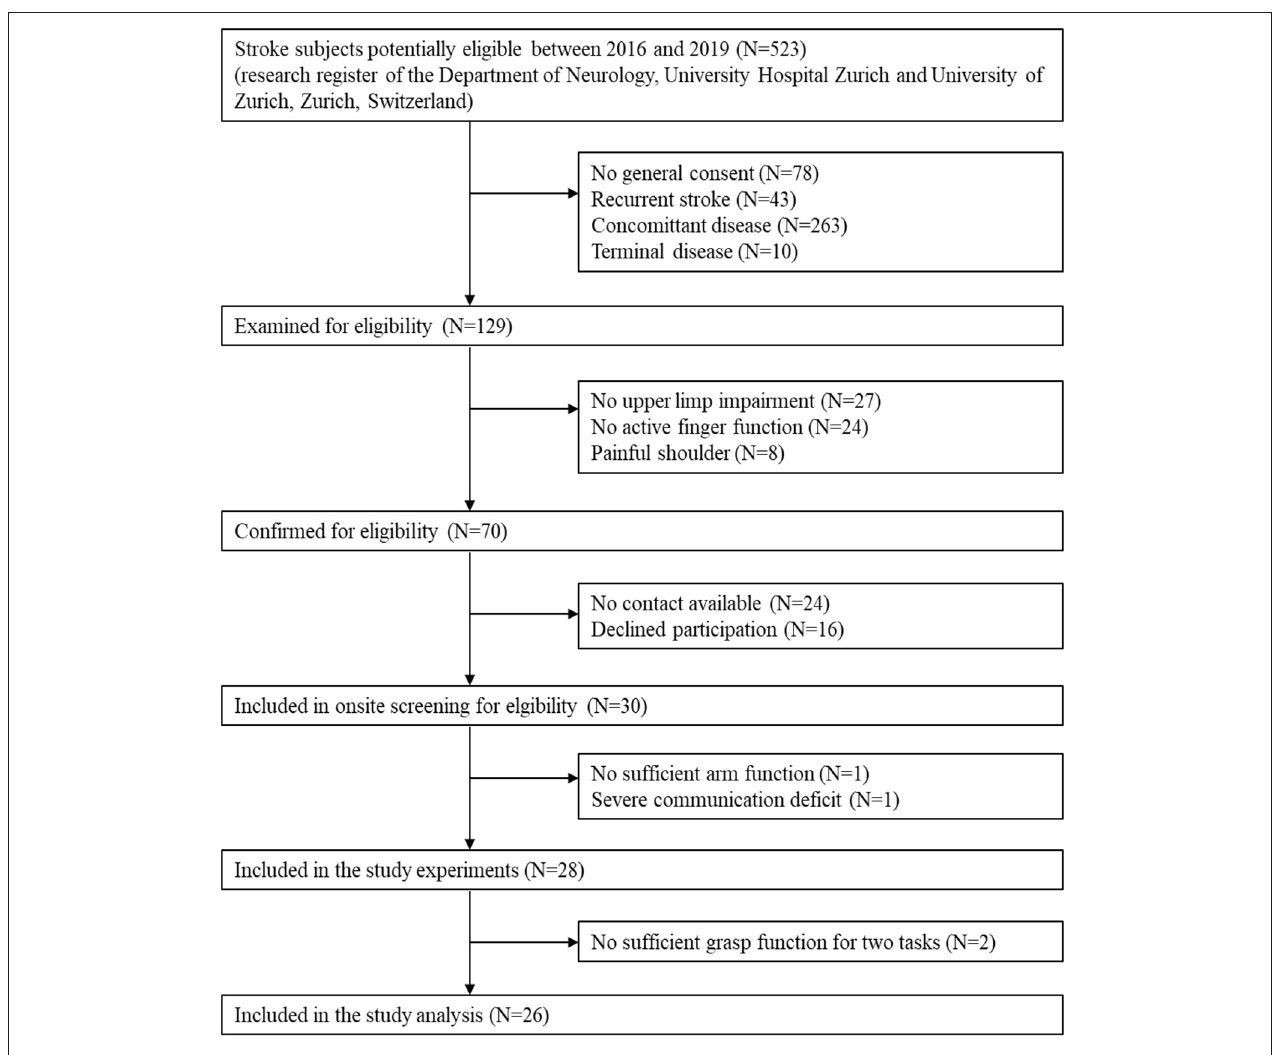
FIGURE 3 | Study flow of the